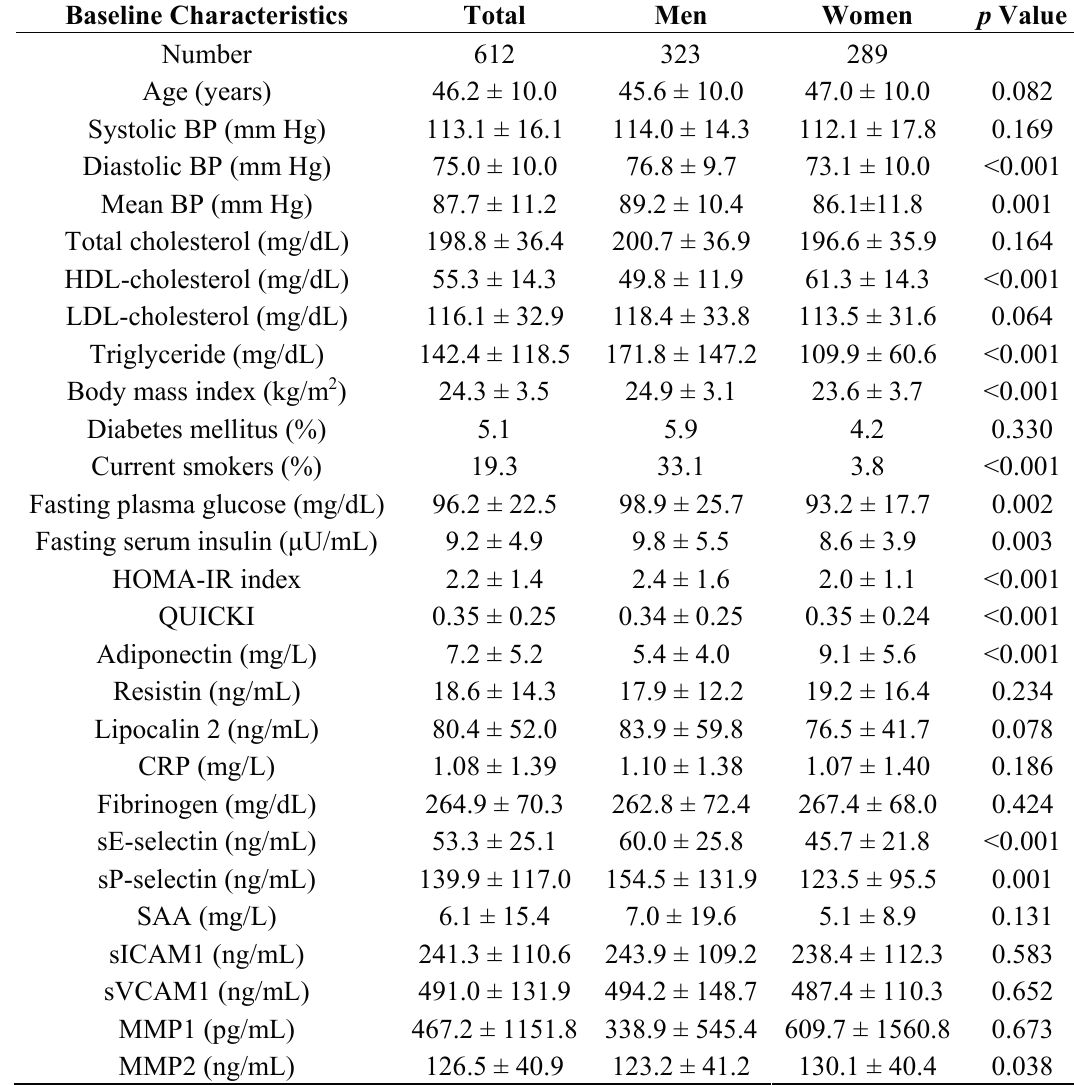
Table 1. Baseline characteristics of the health examination